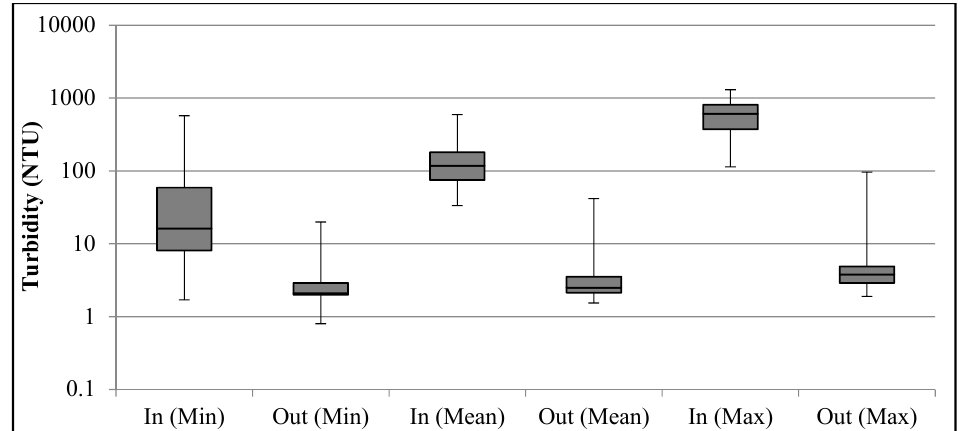
Figure 10. Fall (October and November) inlet and outlet turbidity during runoff events: minimum, mean and maximum.